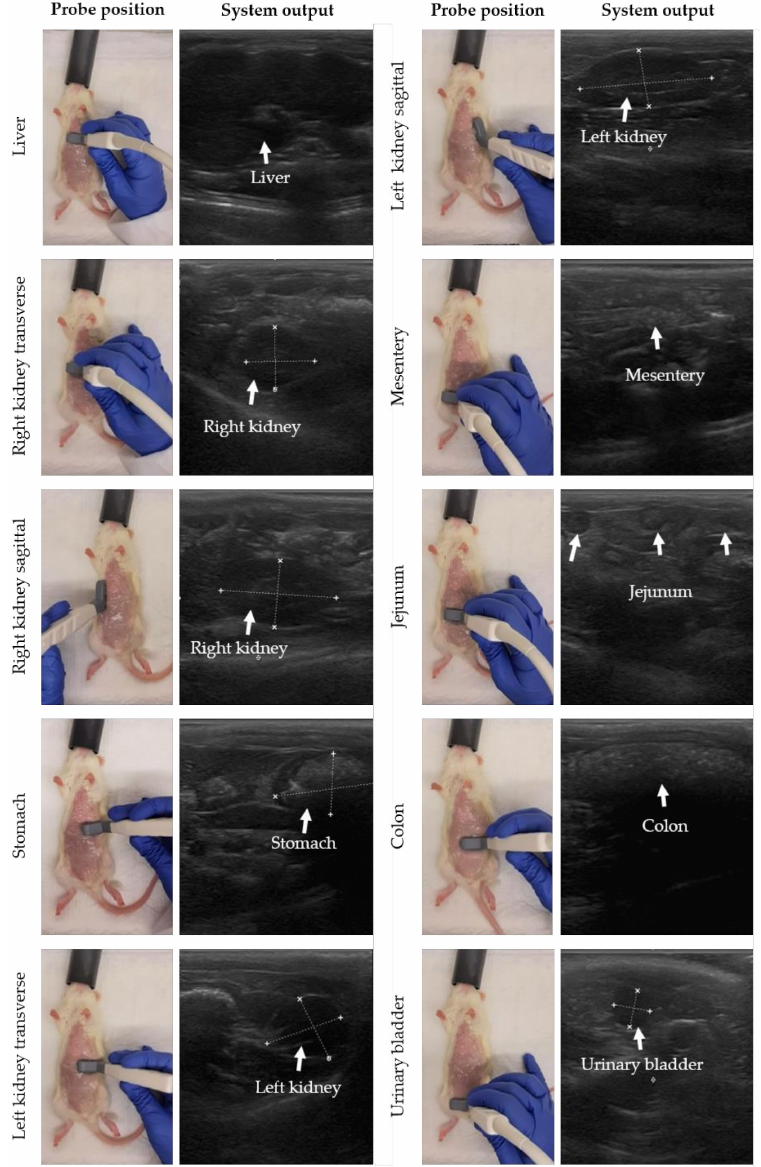
Figure 2. Stepwise movement of probe positions to perform gastrointestinal ultrasound in rats. Before the ultrasound procedure, the abdominal skin was shaved and cleaned with 70% ethanol. For each organ, the probe position with the system output is presented, moving from liver, right kidney, stomach, colon, and left kidney to urinary bladder. In the system output, the organ of interest is highlighted by white measurement marks and/or